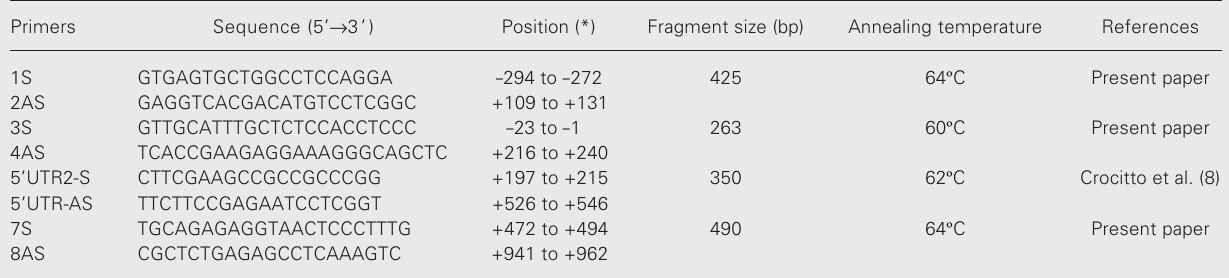
Table 1. Primer sequences used to amplify the androgen receptor 5’UTR promoter region in blood donors and prostate cancer patients.